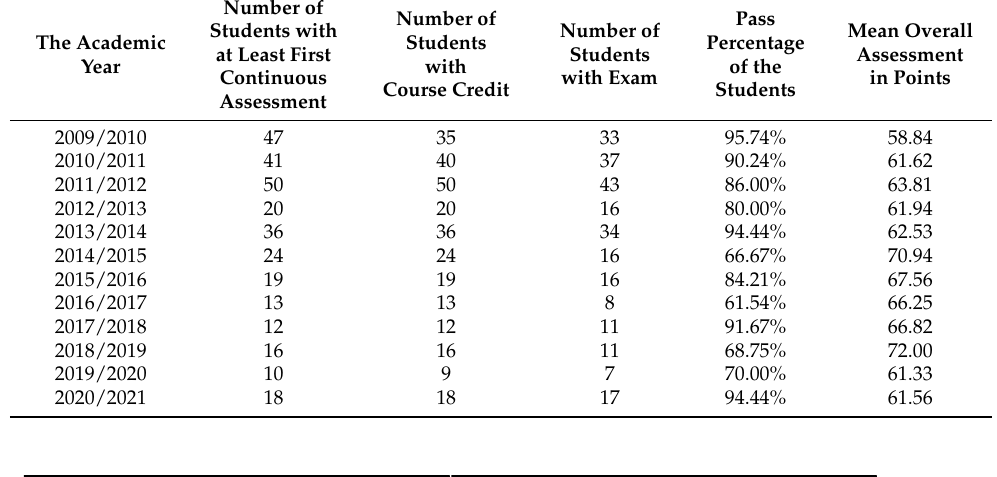
Table 2. Evolution of the number of students and their success rate in the Statistics course.